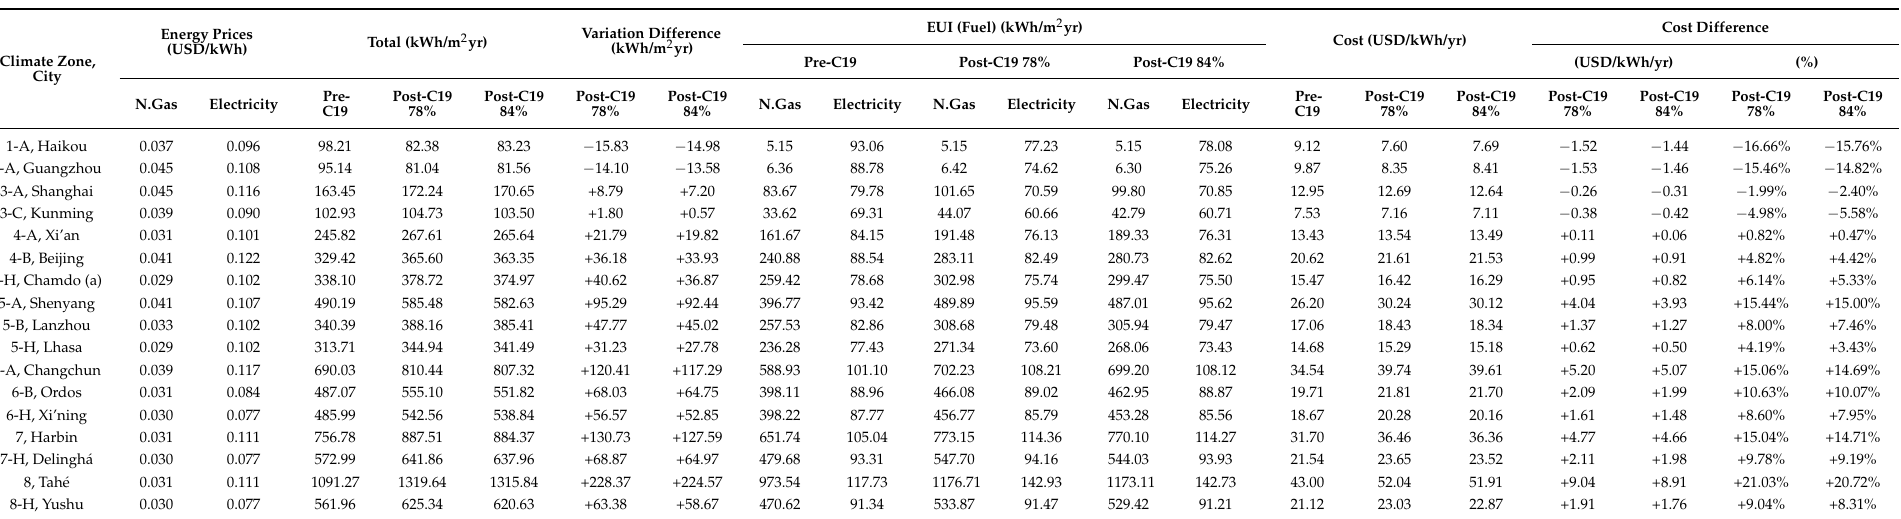
Table A5. Chinese standard office building energy costs comparison on pre- and post-C19 scenario by